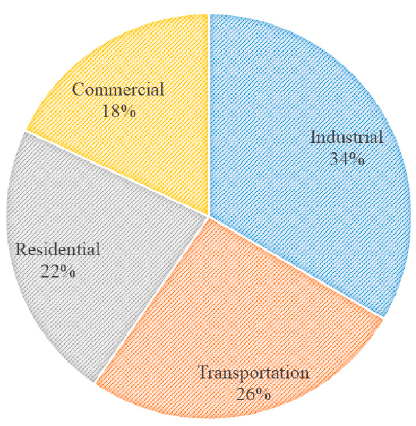
Figure 2. US energy use by end-use sectors in 2020 (Total = 26,651.88 TWh).